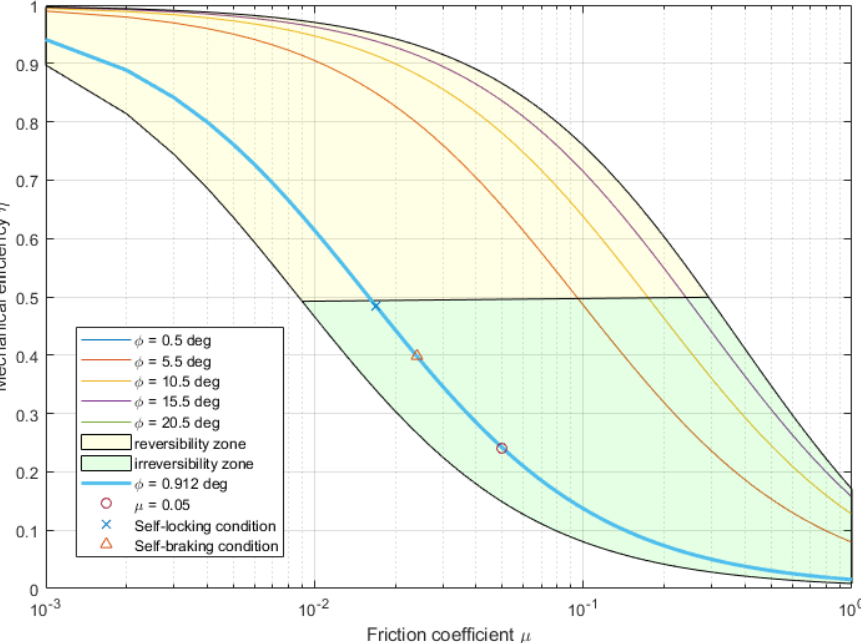
Figure 10. Correlation of the reaction forces determined with increasing dynamic friction coefficients.